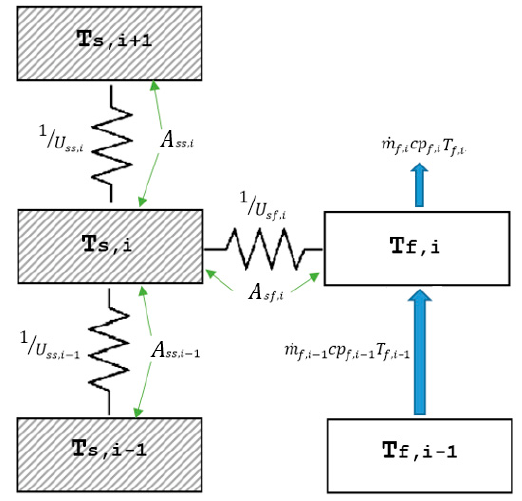
Figure 3. Heat flow for the ith layer.